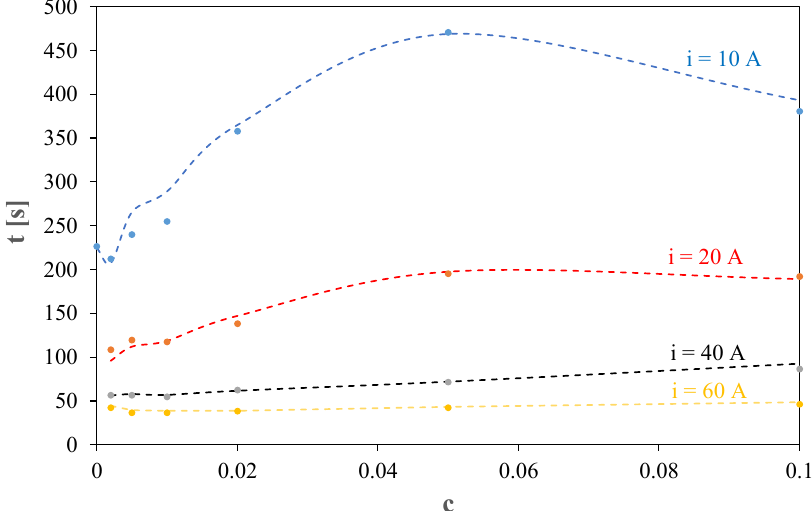
Figure 6. Calculated and measured dependence of time t on the electrolyte concentration.